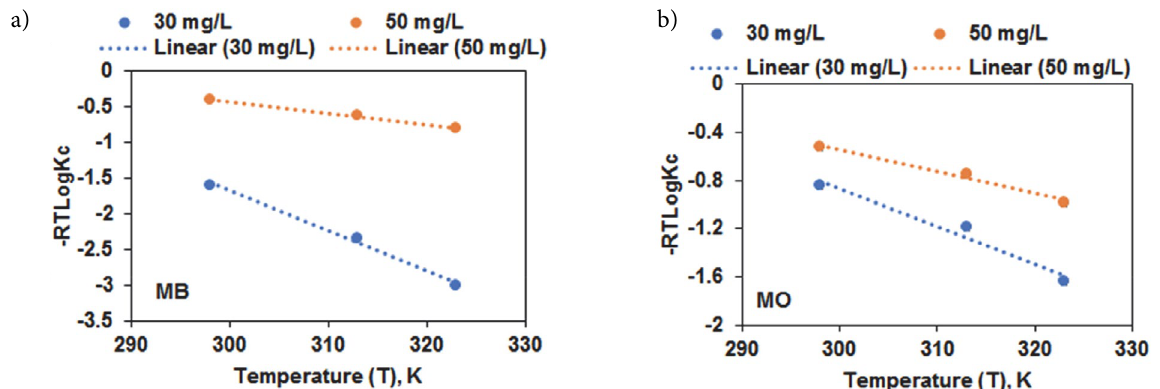
Figure 8. Thermodynamic illustrations ( ΔG 0 = –RT Log Kc vs. T ) of MB and MO adsorption onto GCM at pH 8.0 for MB and pH 6.0 for MO with 2.0 g/L adsorbent dosage for 180 min equilibrium for calculating to thermodynamic parameters ΔH 0 and ΔS 0 .